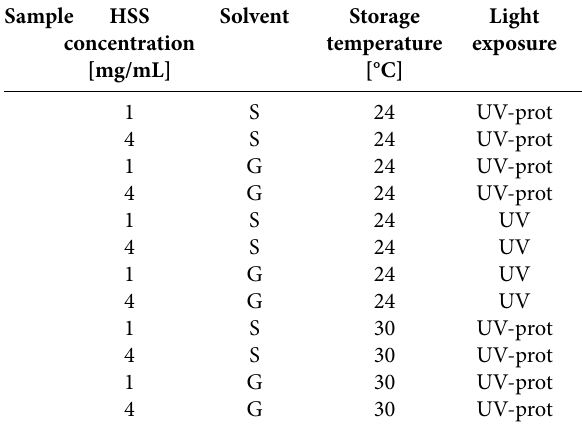
Table 1. Conditions during hydrocortisone sodium succinate (HSS) stability study in isotonic saline (S) and 5% glucose (G) solutions for